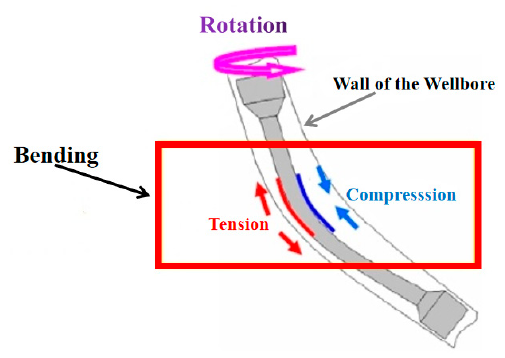
Figure 1. Schematic illustration of dogleg.